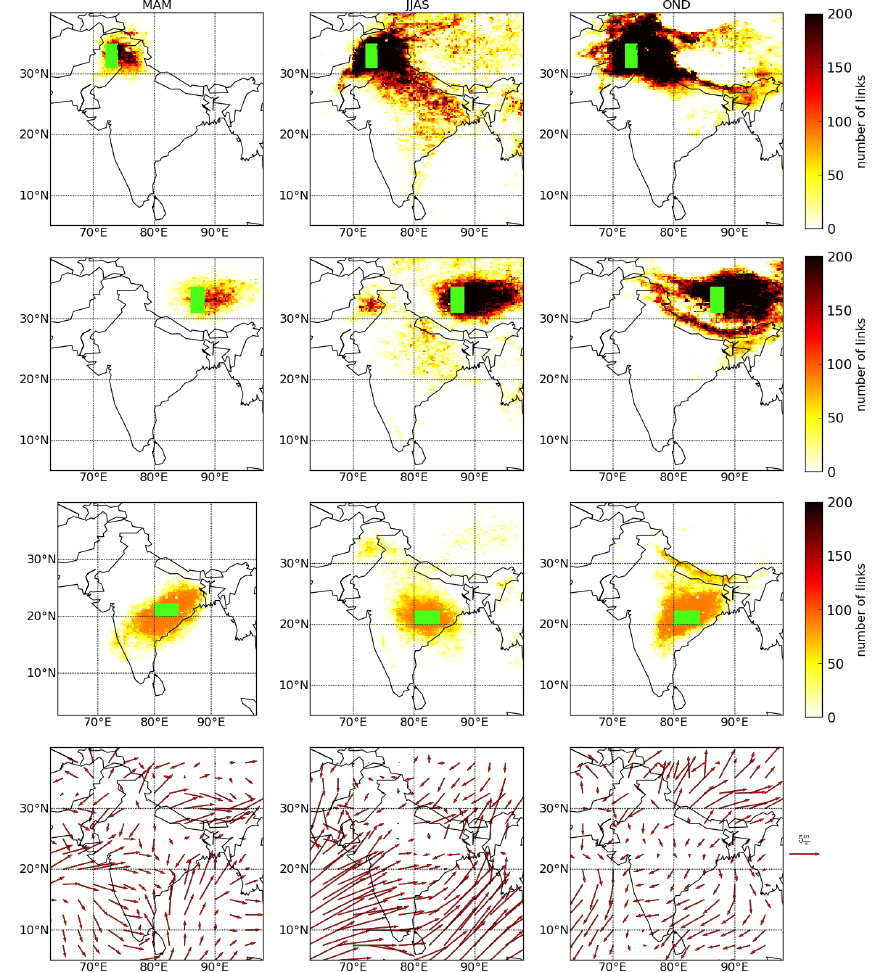
Figure 5. Links between a set of 153 reference grid points and other grid points, and the surface wind vector mean between 1998 and 2012. From top to bottom: North Pakistan (NP), Tibetan Plateau (TP), Eastern Ghats (EG) (TRMM) and the surface wind vector mean